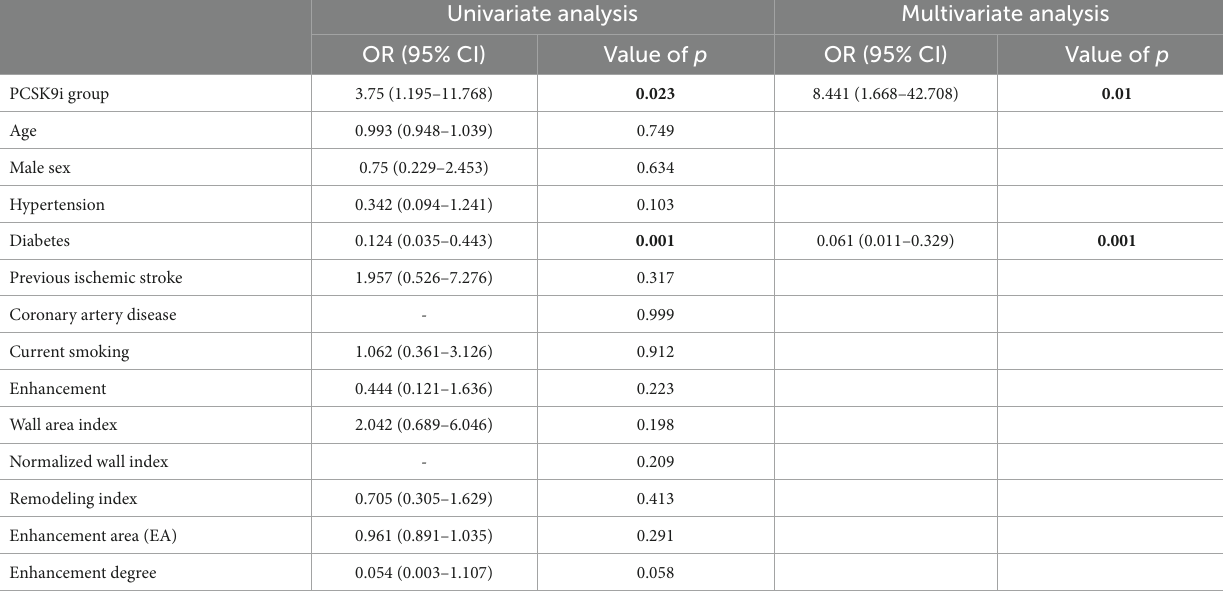
TABLE 6 Univariate and multiple logistic regression analyses for the efficacy of treatment.